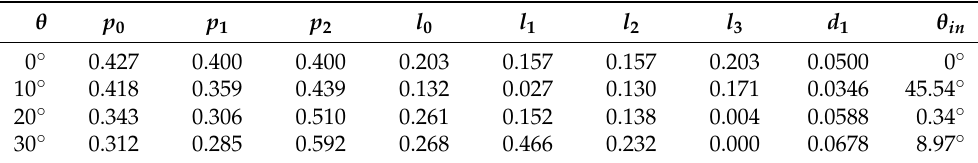
Table 1. The optimum structural parameters for single-beaming effect.